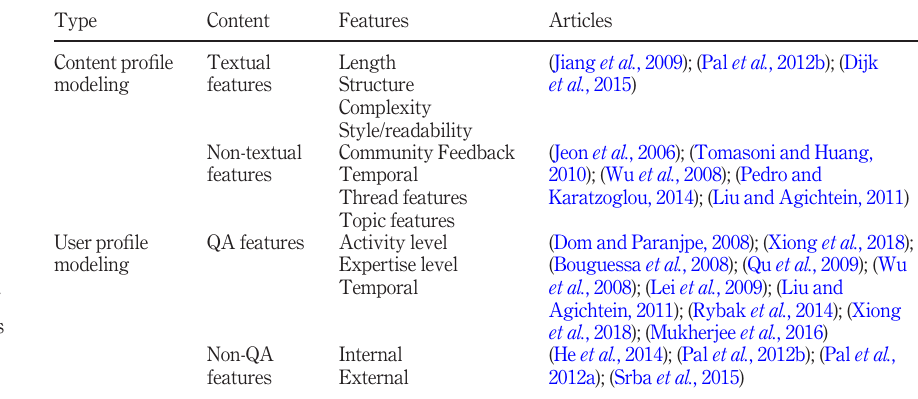
Table I. Categorization of low-level features describing